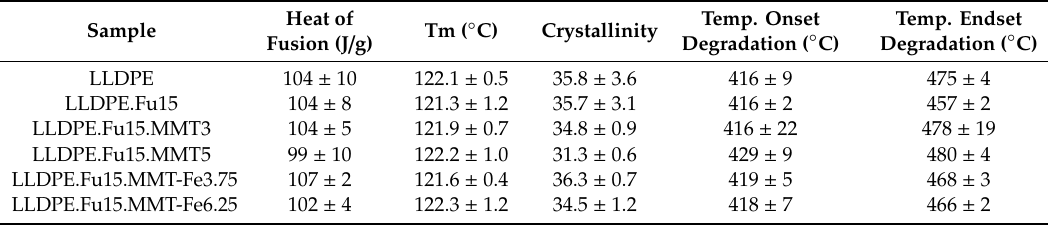
Figure 4. ( a )Thermogravimetric(TG)curvesinflowingairofLLDPE,MMT,MMT-Fe, andnanocomposites Figure 4. ( a ) Thermogravimetric (TG) curves in flowing air of LLDPE, MMT, MMT-Fe, and with di ff erent MMT and MMT-Fe contents. ( b ) Di ff erential scanning calorimetry (DSC) thermograms nanocomposites with different MMT and MMT-Fe contents. ( b ) Differential scanning calorimetry of LLDPE and LLDPE nanocomposites. (DSC) thermograms of LLDPE and LLDPE nanocomposites. Table 2. Thermal properties of LLDPE and LLDPE Table 2. Thermal properties of LLDPE and LLDPE nanocomposites.